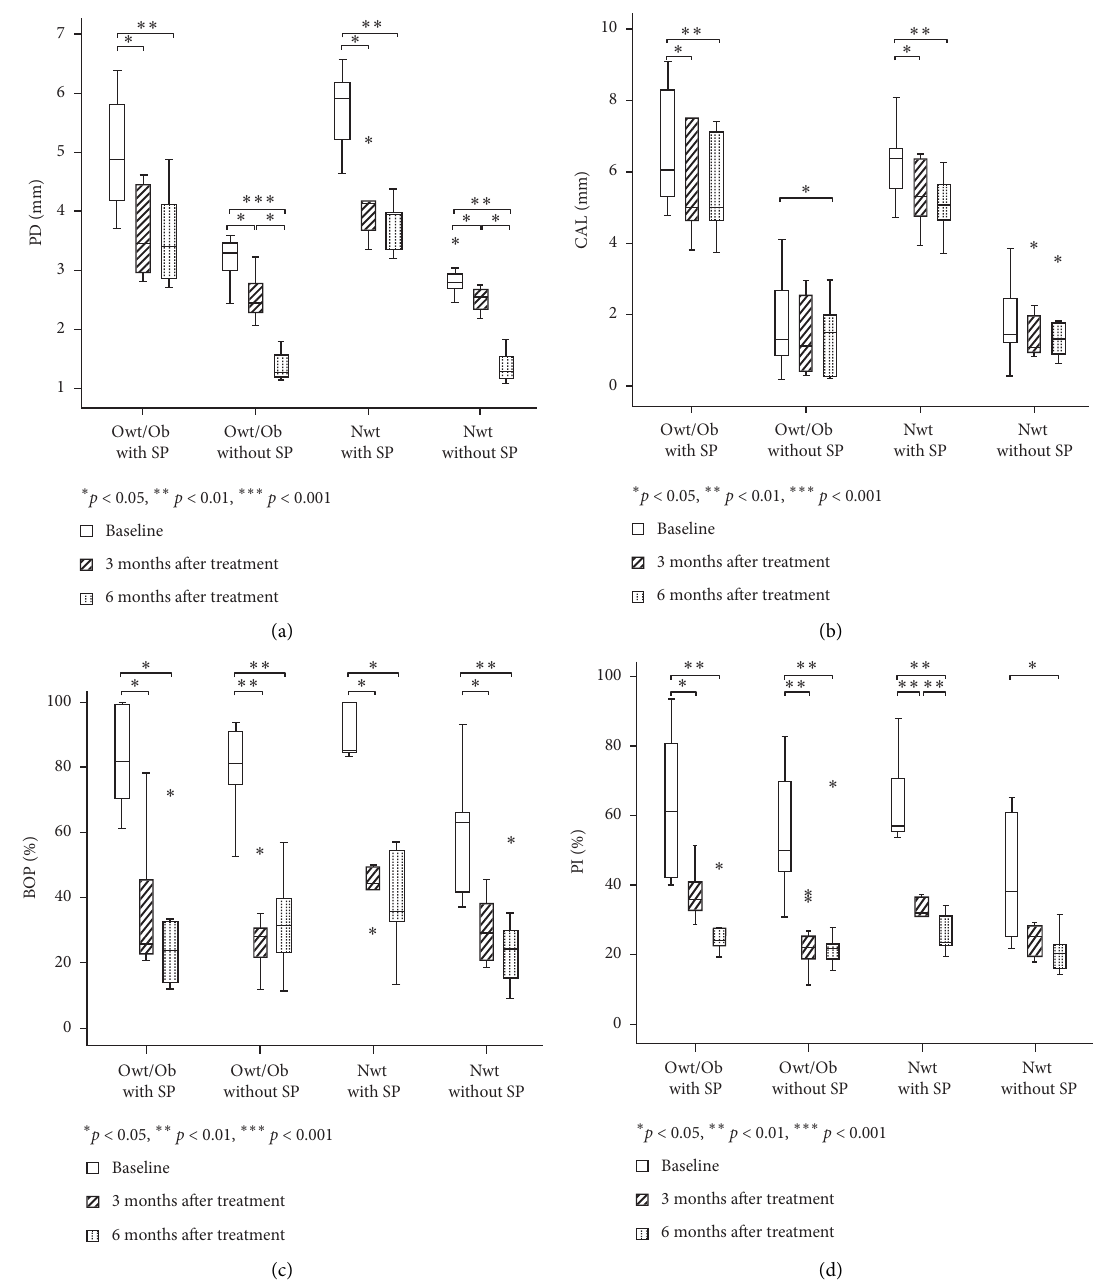
Figure 1: Periodontal parameters and plaque scores at baseline, as well as at 3 and 6 months after NSPT, according to body mass index (BMI) and periodontal disease status: (a) probing depth (PD), (b) clinical attachment level (CAL), (c) bleeding on probing (BOP), and (d) plaque (Pl) score. Differences were compared by the Friedman test; significant differences for pairwise comparisons were determined by the Wilcoxon matched-pairs signed-rank